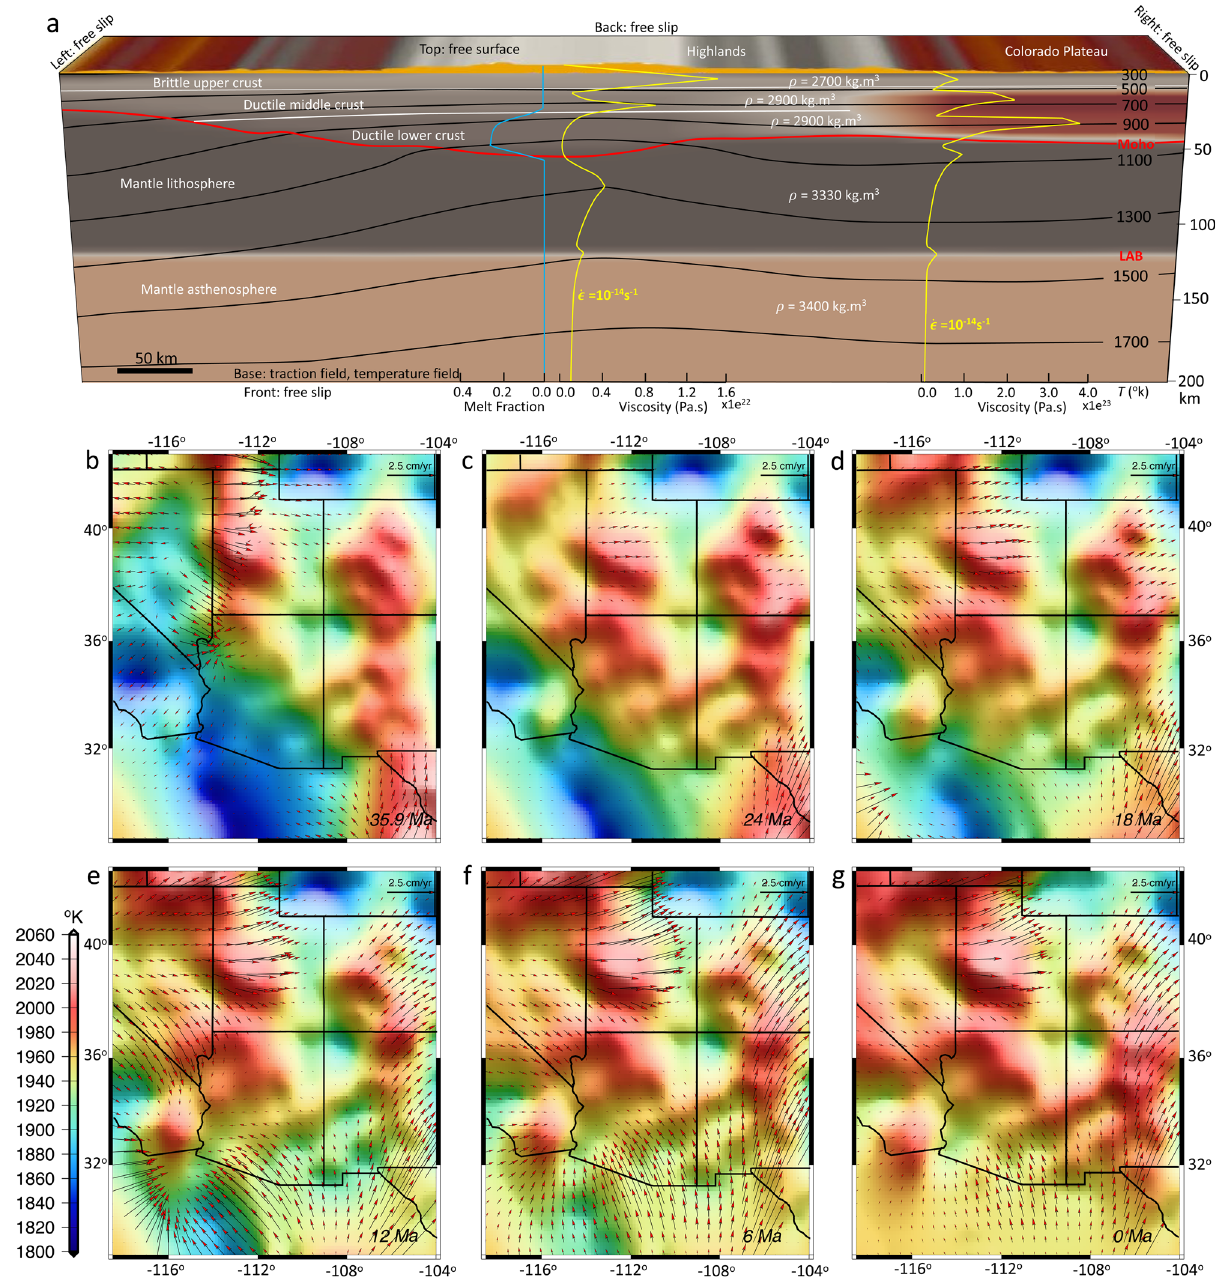
Fig. 5 Model setup and boundary conditions for the 4-D thermo-mechanical model of the lithosphere. a Model geometry, parameters and boundary conditions, temperature, and strength as a function of depth. The yellow graphs represent the de fi ned starting viscosities based on a constant strain rate of 1e − 14 s − 1 . LAB: lithosphere-asthenosphere boundary; T: temperature; ρ : density. b – g Temperature variations at 200 km depth used in thermo-mechanical modeling of the lithosphere at 35.9, 24, 18, 12, 6, and 0 Ma, respectively. Red arrows represent kinematic fi eld associated with sub-lithosphere tractions from mantle convection at 200 km depth. Black lines are the present-day state boundaries. The map images were created by authors using: www.soest. hawaii.edu/gmt/ and